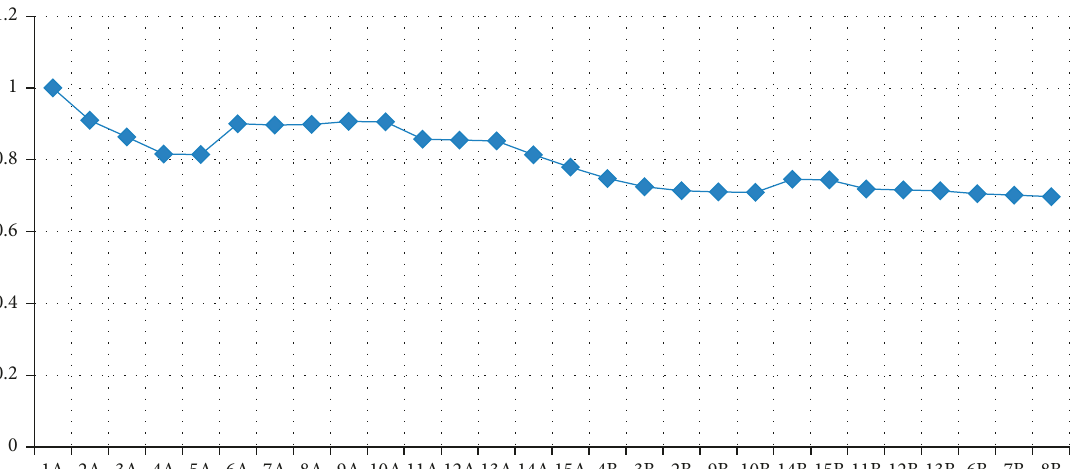
Figure 12: Voltage magnitudes of topology structure presented in Figure